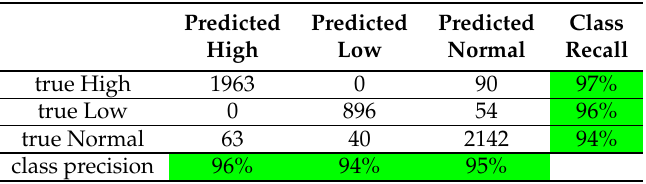
Table 9. Confusion matrix for